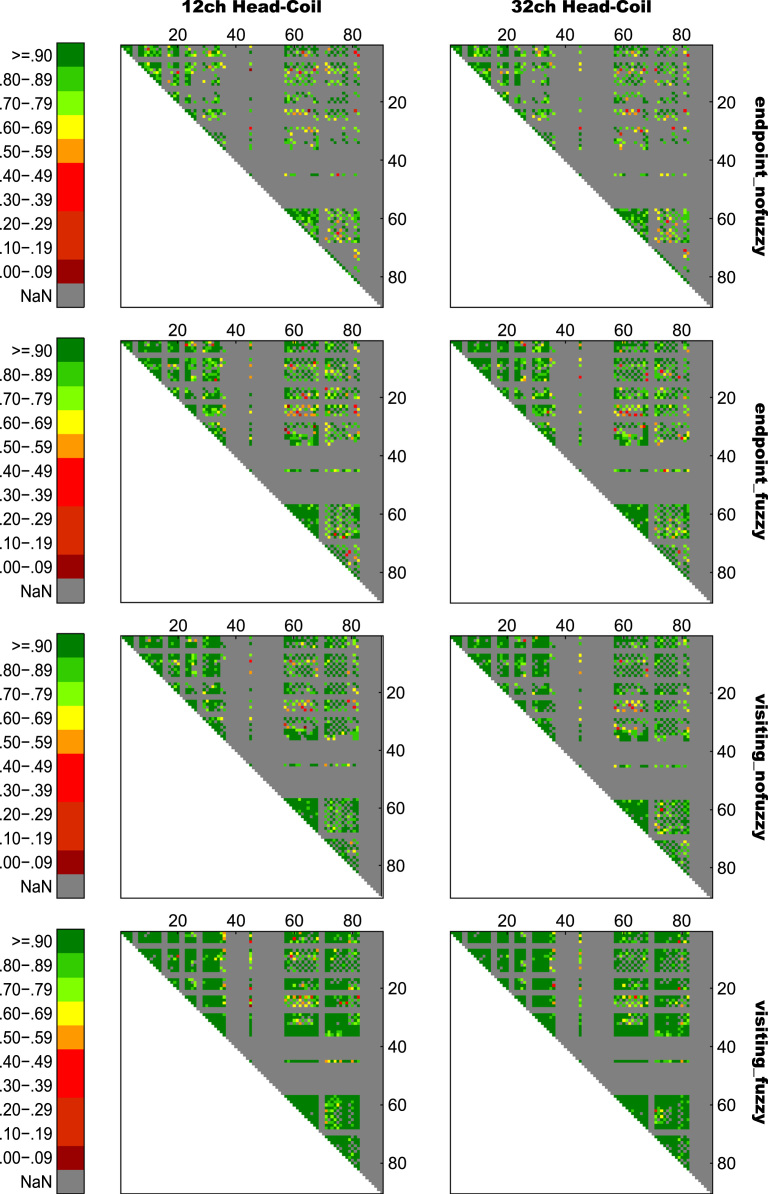
Seed-specific ICC(2,1) values for all connections of Model 3, estimating the within-session reproducibility of all eight variants of type of head-coil×streamline selection variant. Numbers on the x- and y-axis refer to AAL seed numbers. For visualization purposes, negative ICC(2,1) values were set to zero (0.01% of values).